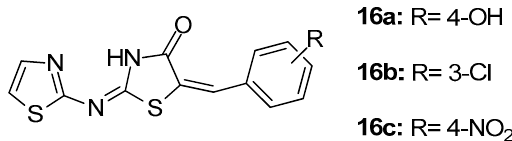
Figure 18. Chemical structures of 5-arylidene-4-thiazolidinones 16a – c .